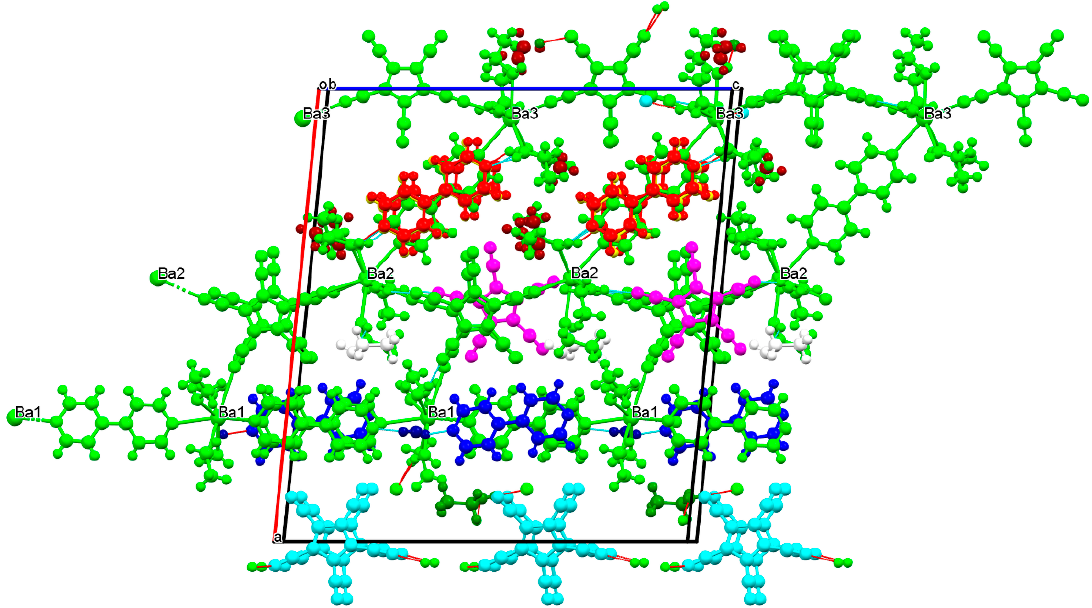
Figure 24 . ( left ) The triple 4,4 ′ -bipy bridging between Ba2 and Ba3. ( right ) The single 4,4 ′ -bipy bridging between two symmetry-related Ba1 ions, supported by π – π -stacking interactions with two more bipyridines.